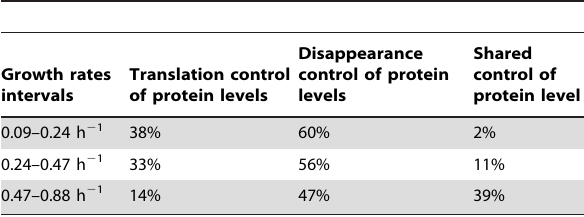
Table 5. Protein control analysis in the different ranges of growth rate based on r t